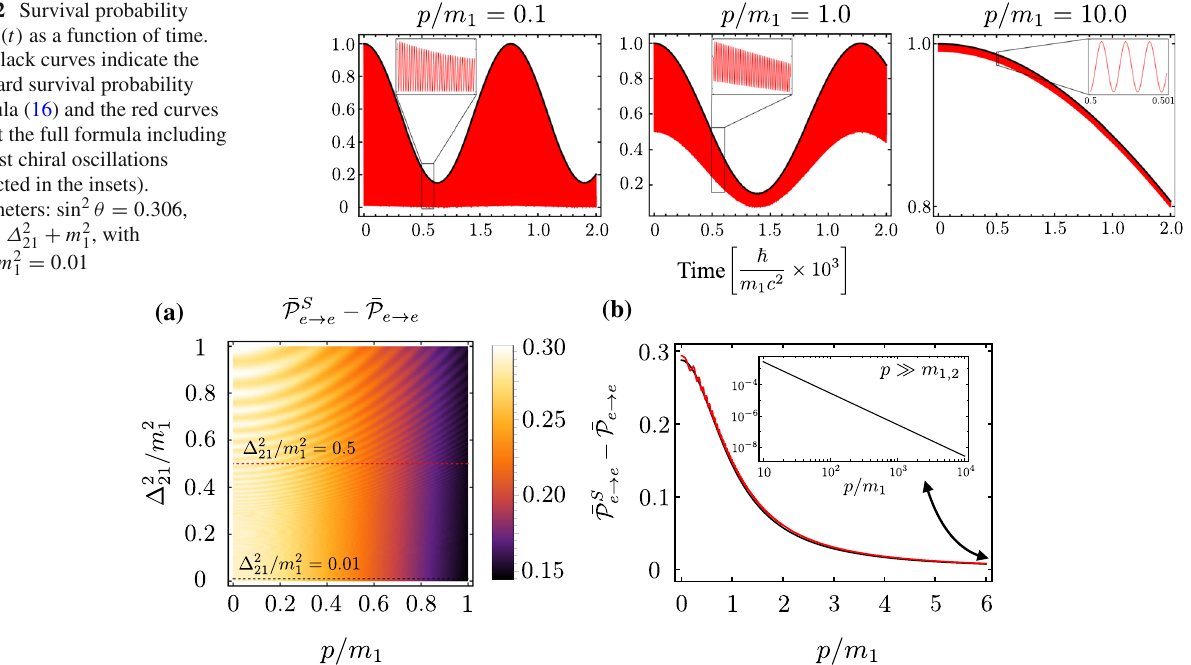
/ m 2 = 0 . 01 (black) and 0 . 5 (red). The 21 1 / m 2 = 0 . 01 in logarithmic scale. Other 21 1